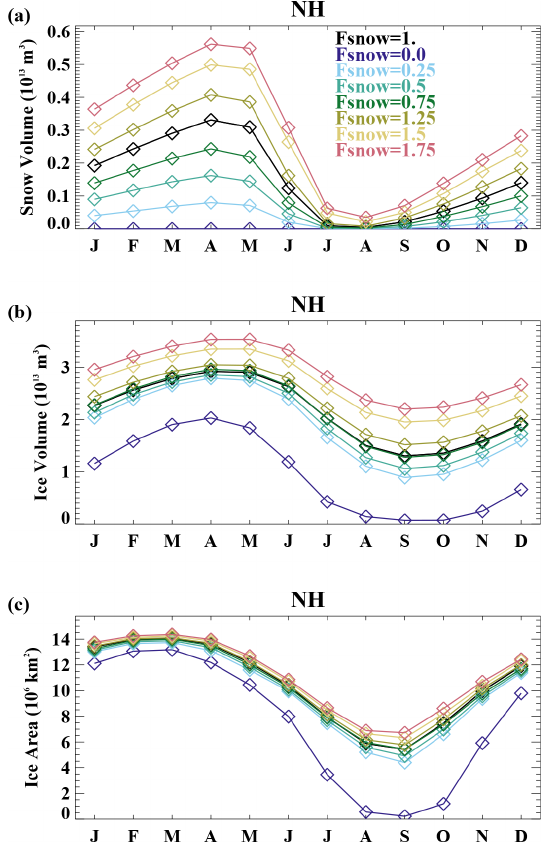
Figure 3. The Northern Hemisphere (a) snow volume, (b) ice vol- ume, and (c) ice area in the different F snow